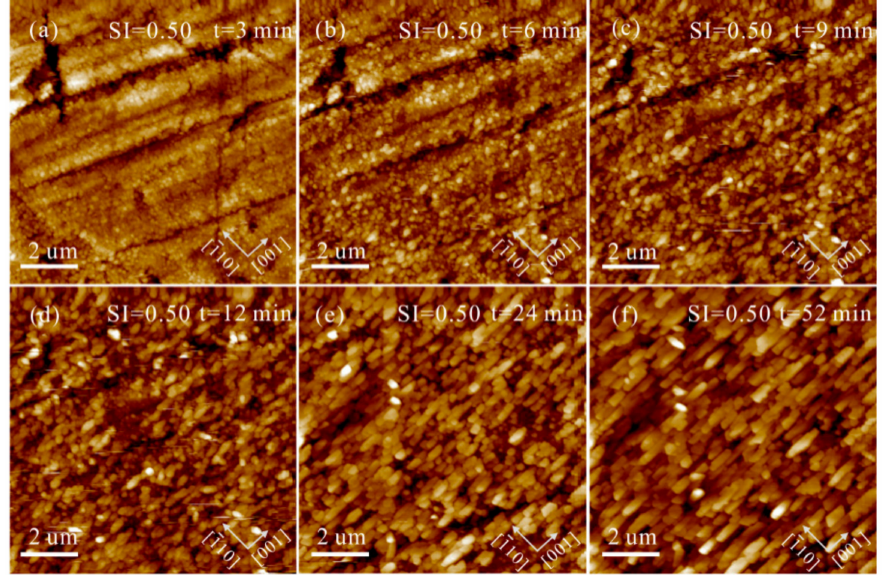
Figure 4. AFM height images of the polished aragonite (110) surface in solution (Mg 2 + / Ca 2 + = 0, SI calcite = 0.50) under static conditions at pH = 8.0 ± 0.1 for ( a ) 3, ( b ) 6, ( c ) 9, ( d ) 12, ( e ) 24 and ( f ) 52